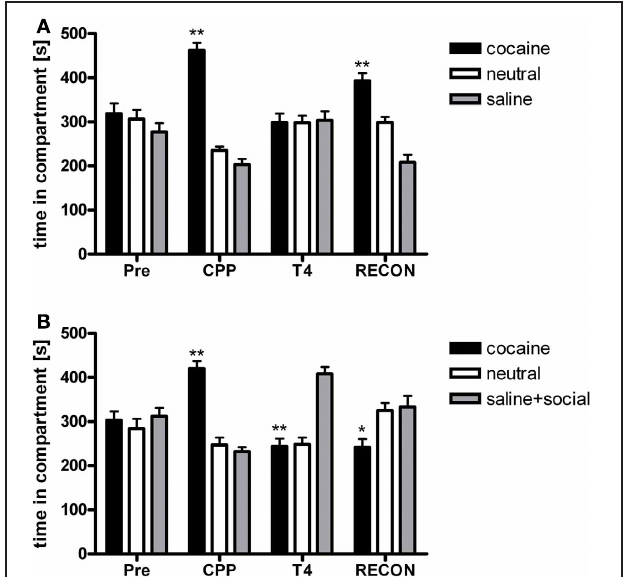
FIGURE 1 | Social interaction during extinction reverses cocaine CPP and inhibits reinstatement of cocaine CPP. PRE, preconditioning test; CPP, conditioned place preference test; T4, conditioned place preference test during extinction in absence (panel A) or presence (panel B) of social interaction made available in the initially saline-associated compartment; RECON, reinstatement test. Shown is time spent in the cocaine, neutral, or saline-associated compartment (group means ± SEM). ∗ P < 0 . 05 and ∗∗ P < 0 . 01 compared to the time spent in the saline-associated